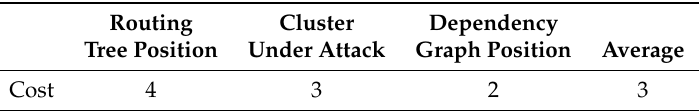
Table 8. Damage cost for sensor 11.